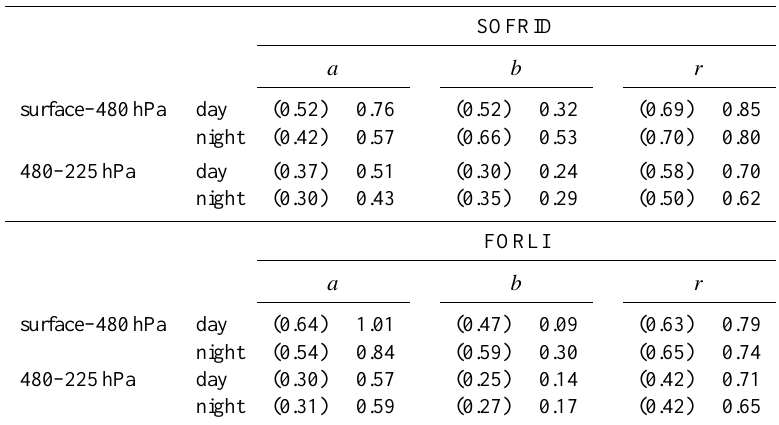
Table 1. Slope ( a ), intercept ( b ) and correlation coefficients ( r ) of the linear least squares fit of CO partial columns computed from MOZAIC profiles and IASI-retrieved profiles (SOFRID – top, FORLI – bottom). Results are given for lower (surface–480hPa) and upper (480–225hPa) tropospheric partial columns of raw (brackets) and smoothed MOZAIC compared to daytime and nighttime IASI retrievals.